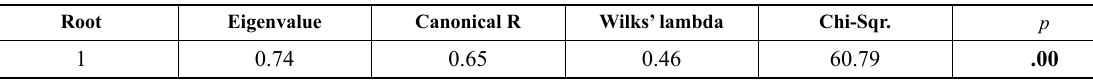
Table 2. Significant discriminant root and p -value Root